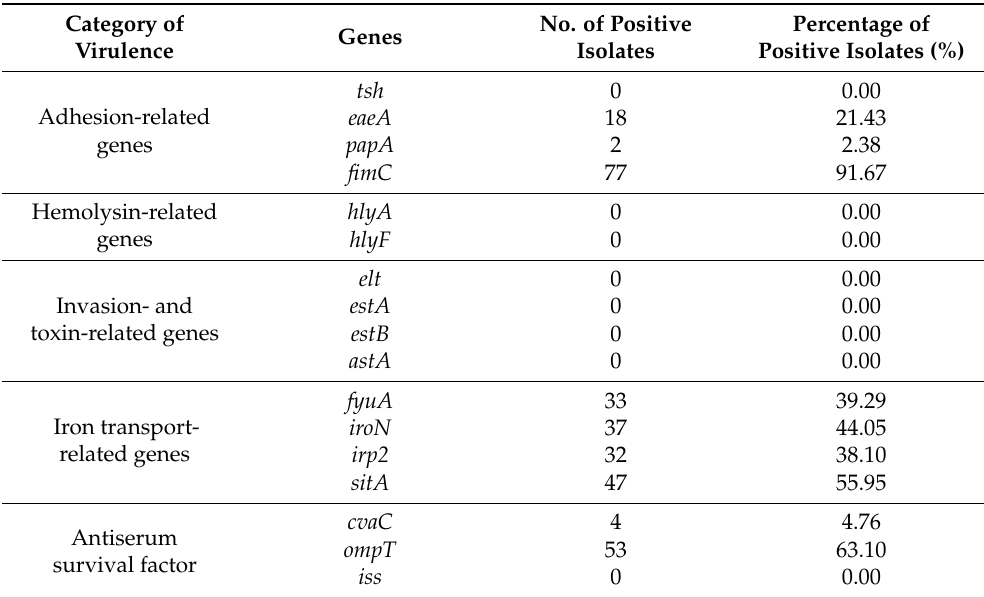
Figure 1. Heat map demonstrating the distribution of antibiotic resistance genes (ARGs) and virulence-associated genes (VAGs) in Escherichia coli ( E. coli ) isolated from captive giant pandas in Sichuan, China. The color scale and the corresponding value indicate the number of E. coli isolates carrying corresponding abscissa and ordinate genes. The prevalence of ARGs ( A ), VAGs ( B ), ARGs and VAGs ( C ) in E. coli isolates. bla TEM , tetA and fimC were the highly prevalent genes among all tested ARGs and VAGs. Table 1. Distribution of virulence-associated genes detected in E. coli isolated from captive giant pandas (n =